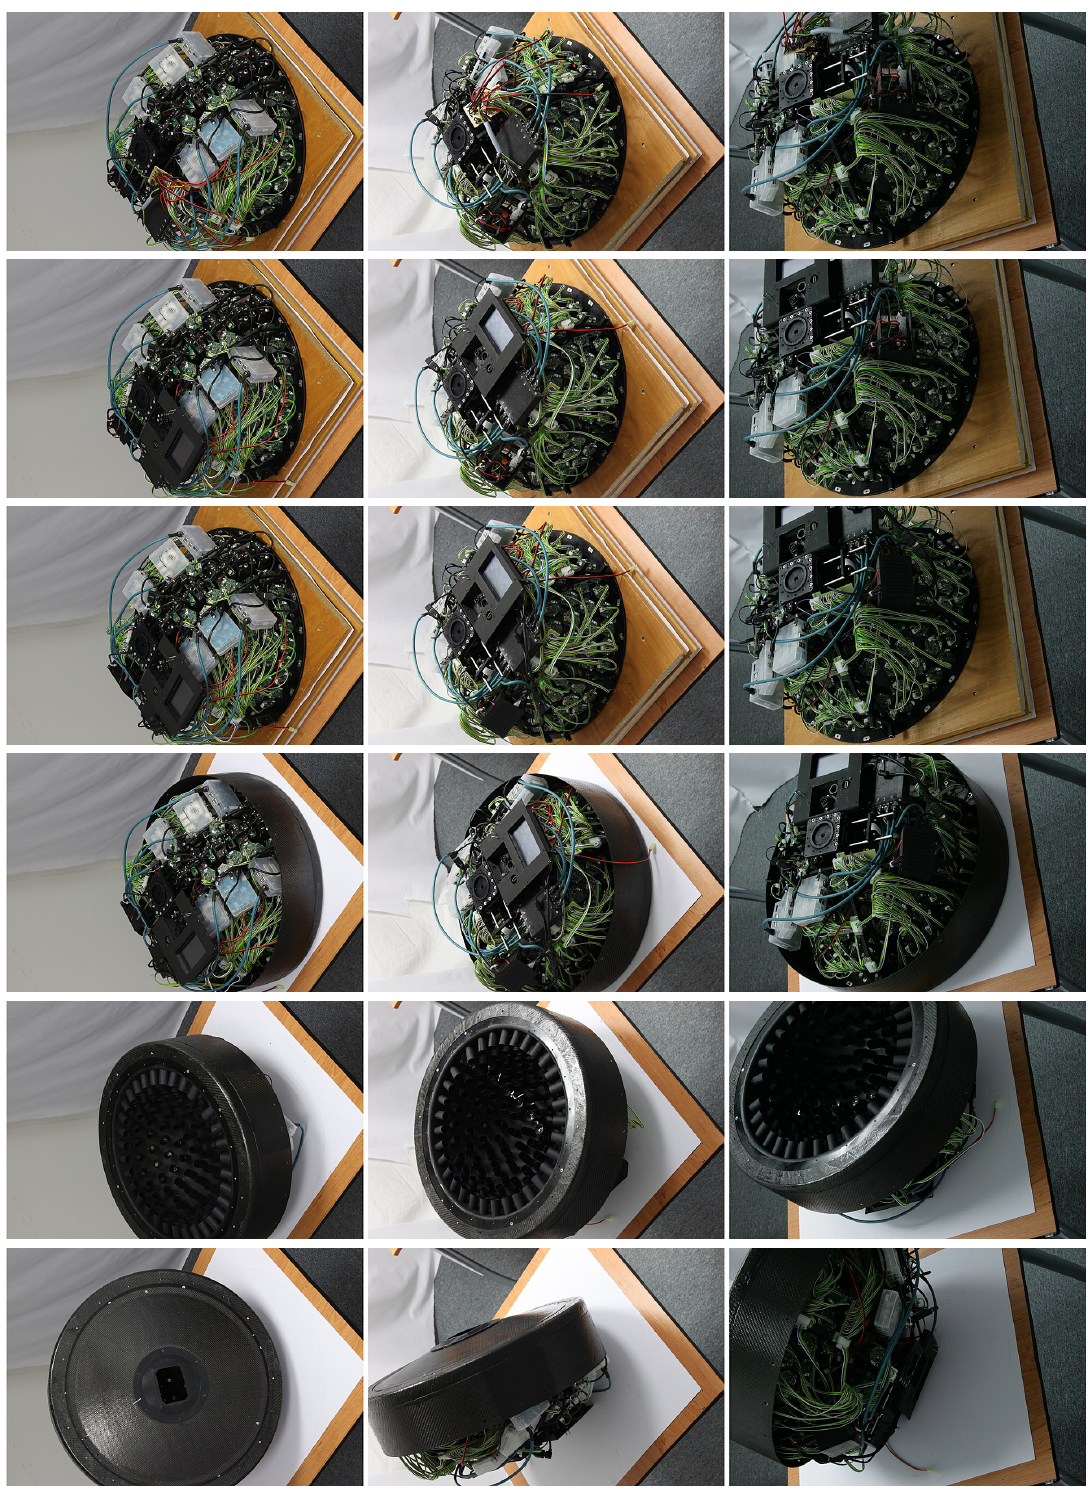
Figure A4. Assembly of lightdrum, step 19 to 24 from three different views. Row 1: adding the input power cable to the main socket; Row 2: connecting the input power cable to the power socket in the main panel with the display; Row 3: connecting the display to the Raspberry Pi 2; Row 4: mounting the carbon cylindrical cover part from bottom; Row 5: view to the gantry from bottom, the baffler is created by the set of LED module tubes; Row 6: mounting the bottom conic carbon cover, extended by 3D printed endpiece that contains the measurement